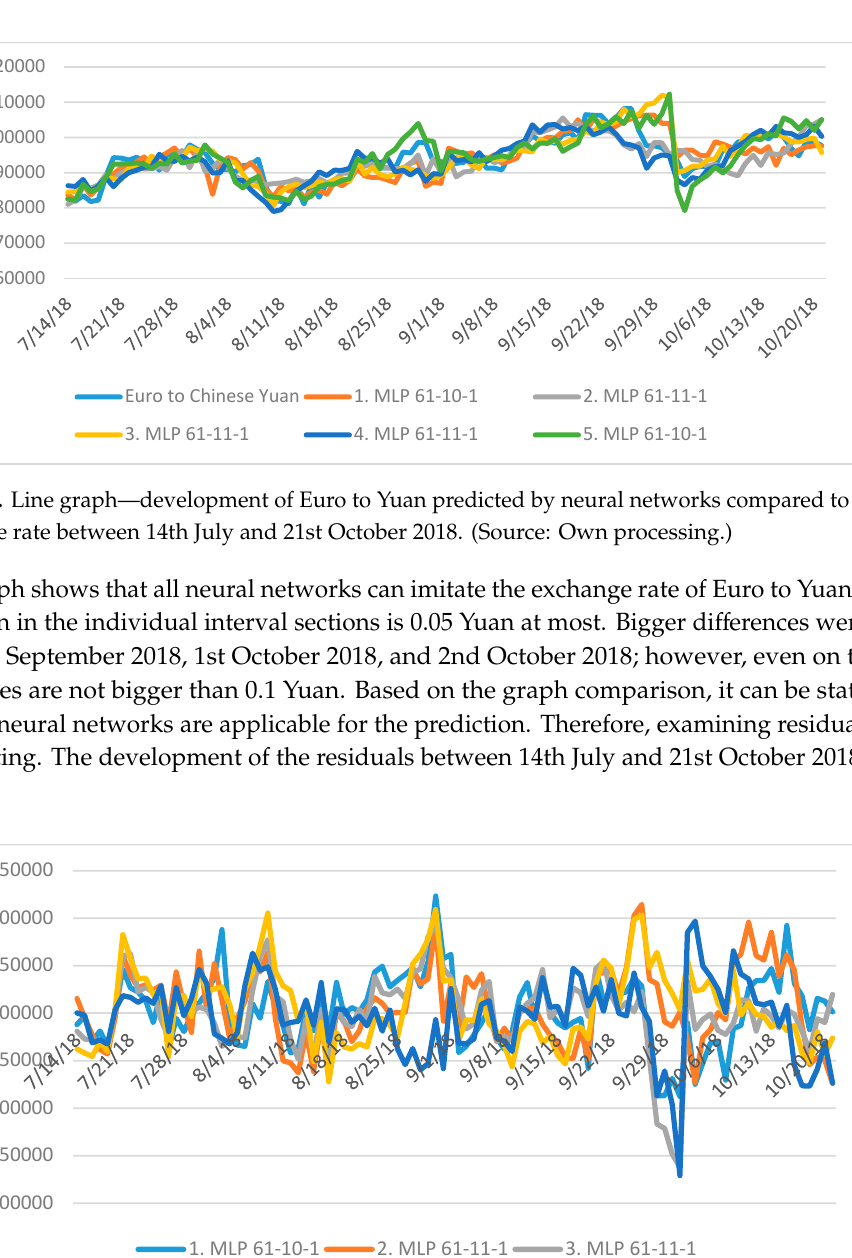
Figure 7. Line graph—development of Euro exchange rate to Yuan predicted by neural networks in comparison with the actual exchange rate in the monitored period. (Source: Own processing.)